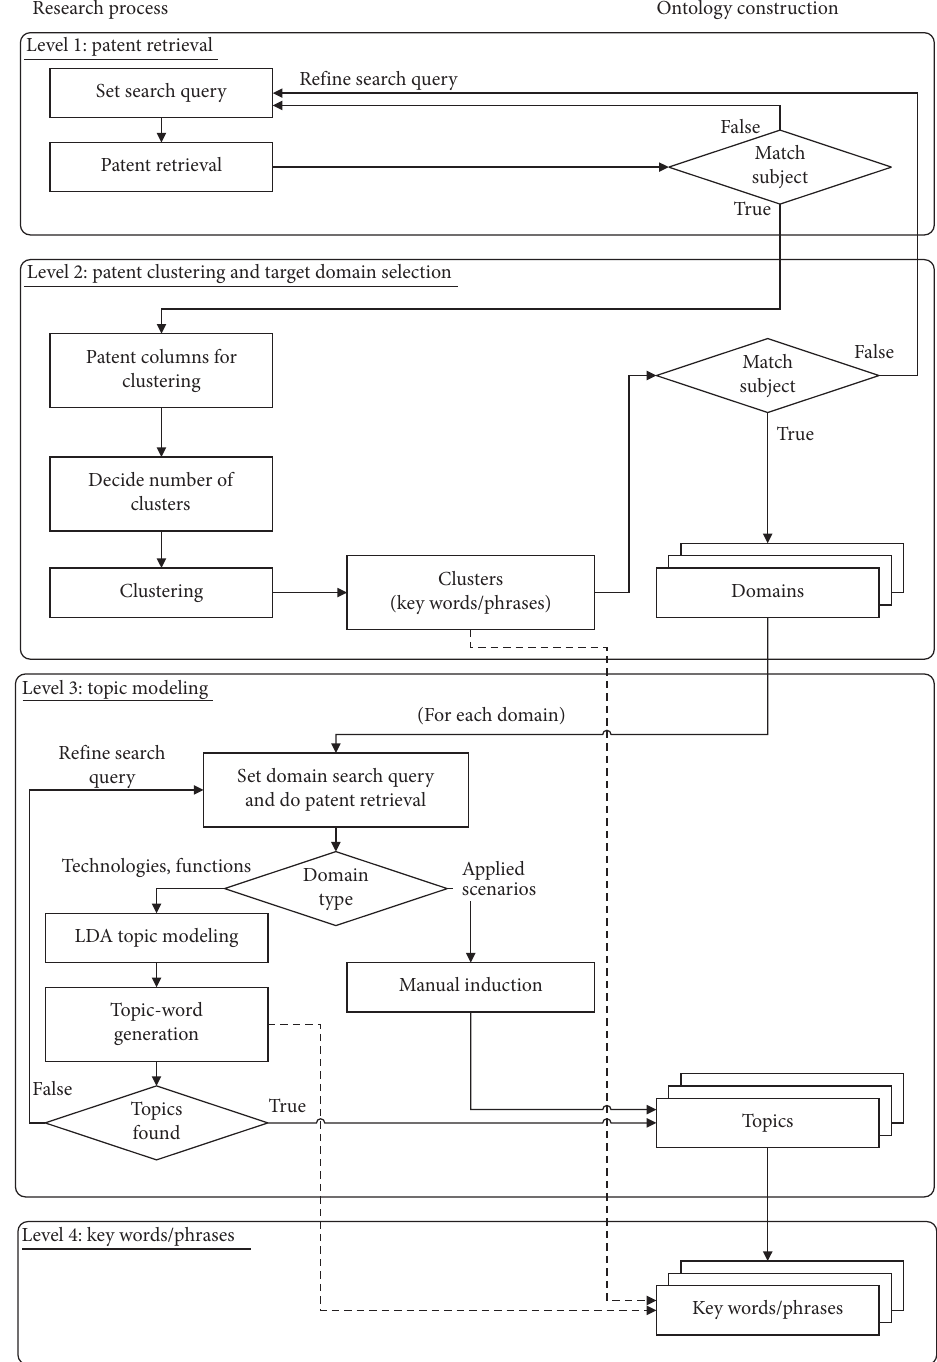
Figure 1: The ontology construction process